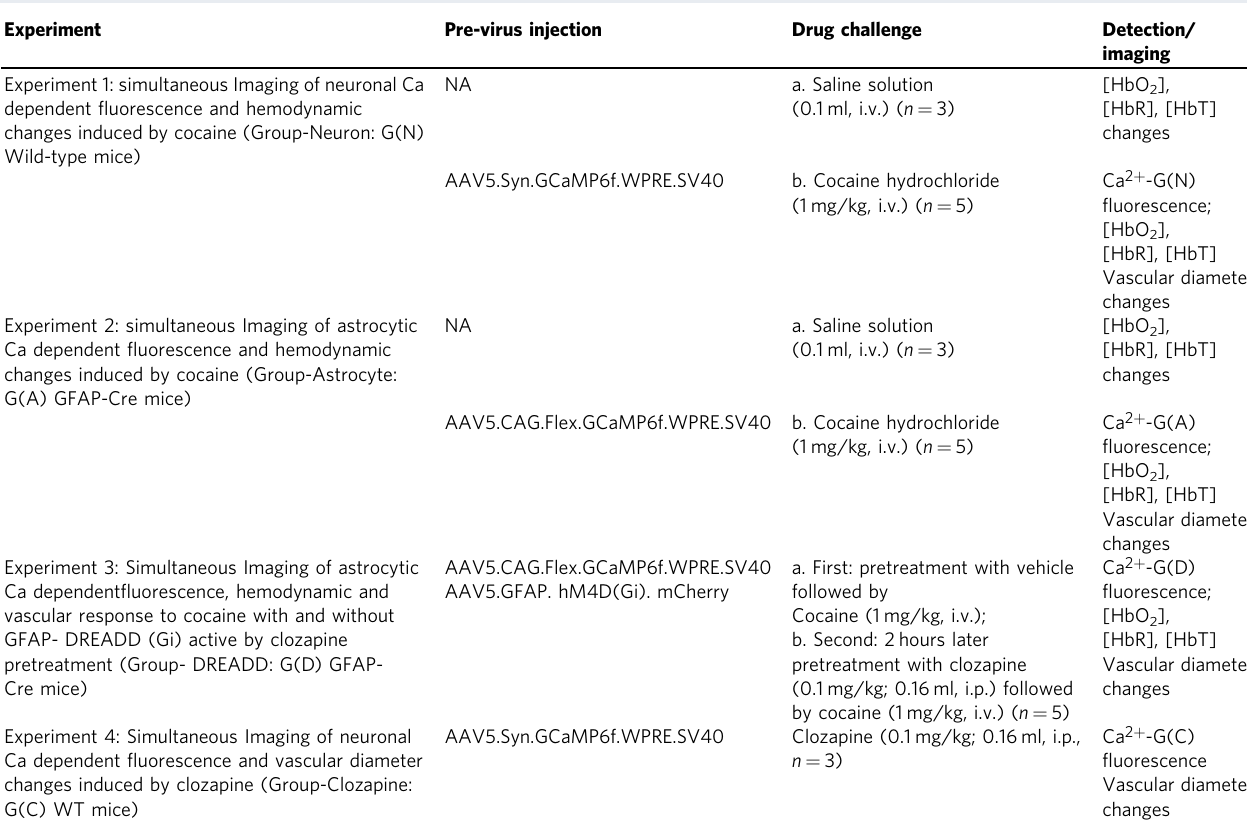
Table 1 Animal groups and experimental